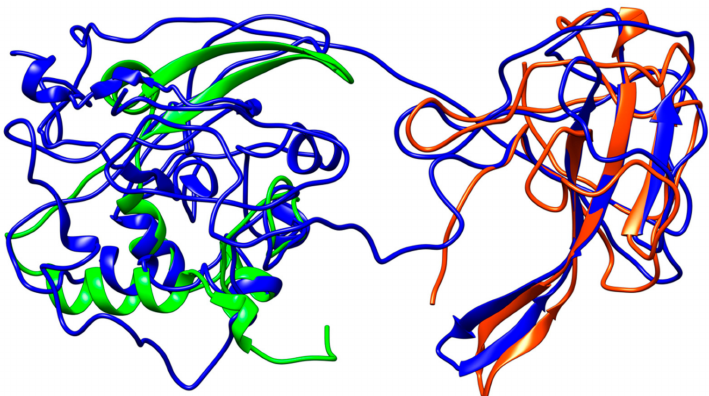
Figure 7. Structural representation of the homology model for Nucleocapsid monomer from SARS–CoV-2 shown in blue and superpose with the structure of the N-terminal fragment from IBV coronavirus homologue (colored in green, PDB ID: 2BXX) and with the dimerization domain of SARS RdRp (in red, PDB ID: